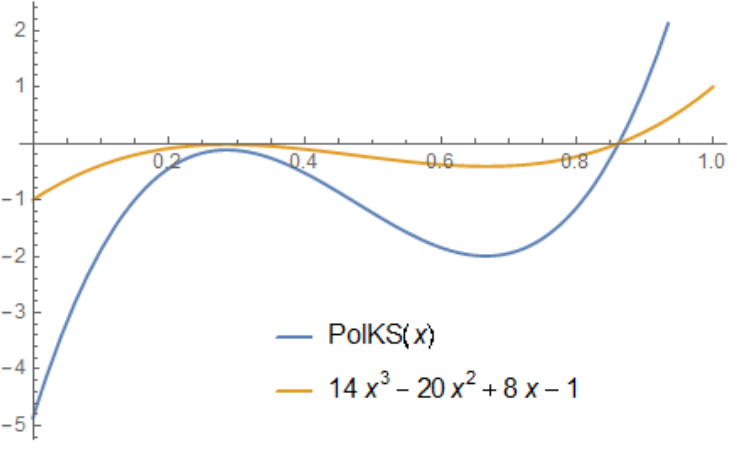
Figure 2. α = 0.1, β = 0.5, m = 500